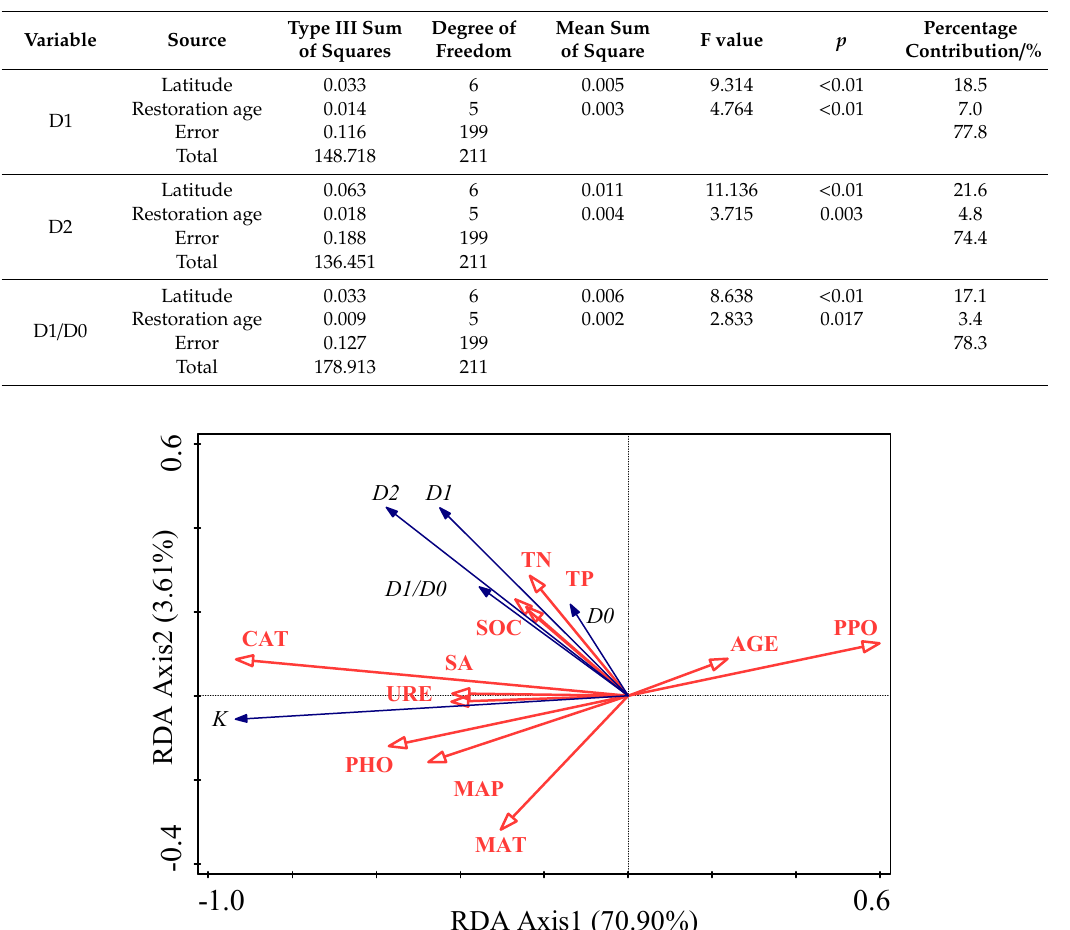
Figure 8. Ordination plot of the redundancy analysis (RDA) for soil erodibility and multifractal dimensions with soil properties as constraining variables. D0 is the capacity dimension; D1 is the information dimension; D2 is the correlation dimension; D1 / D0 is the information dimension / capacity dimension ratio; K is the erodibility factor; SOC is soil organic carbon; TN is total nitrogen; TP is total phosphorus; AGE is restoration age; MAP is mean annual precipitation; MAT is mean annual precipitation; CAT is soil catalase activity; PPO is soil polyphenol oxidase activity; PHO is soil phosphatase activity; URE is soil urease activity; SA is soil saccharase activity.